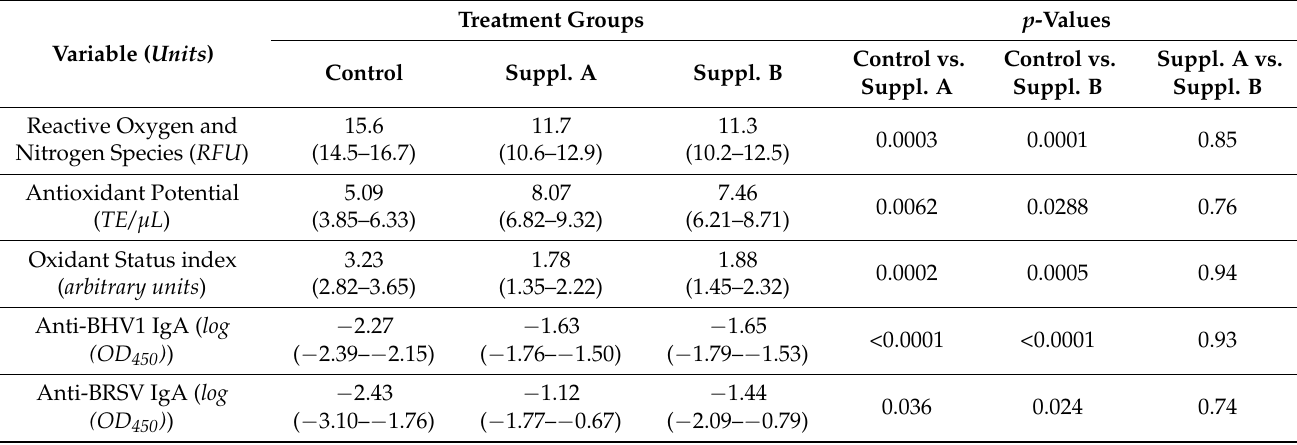
Table 2. Model main effect estimates of treatments for the outcome variables of the study. Results are presented as least squared means and 95% confidence